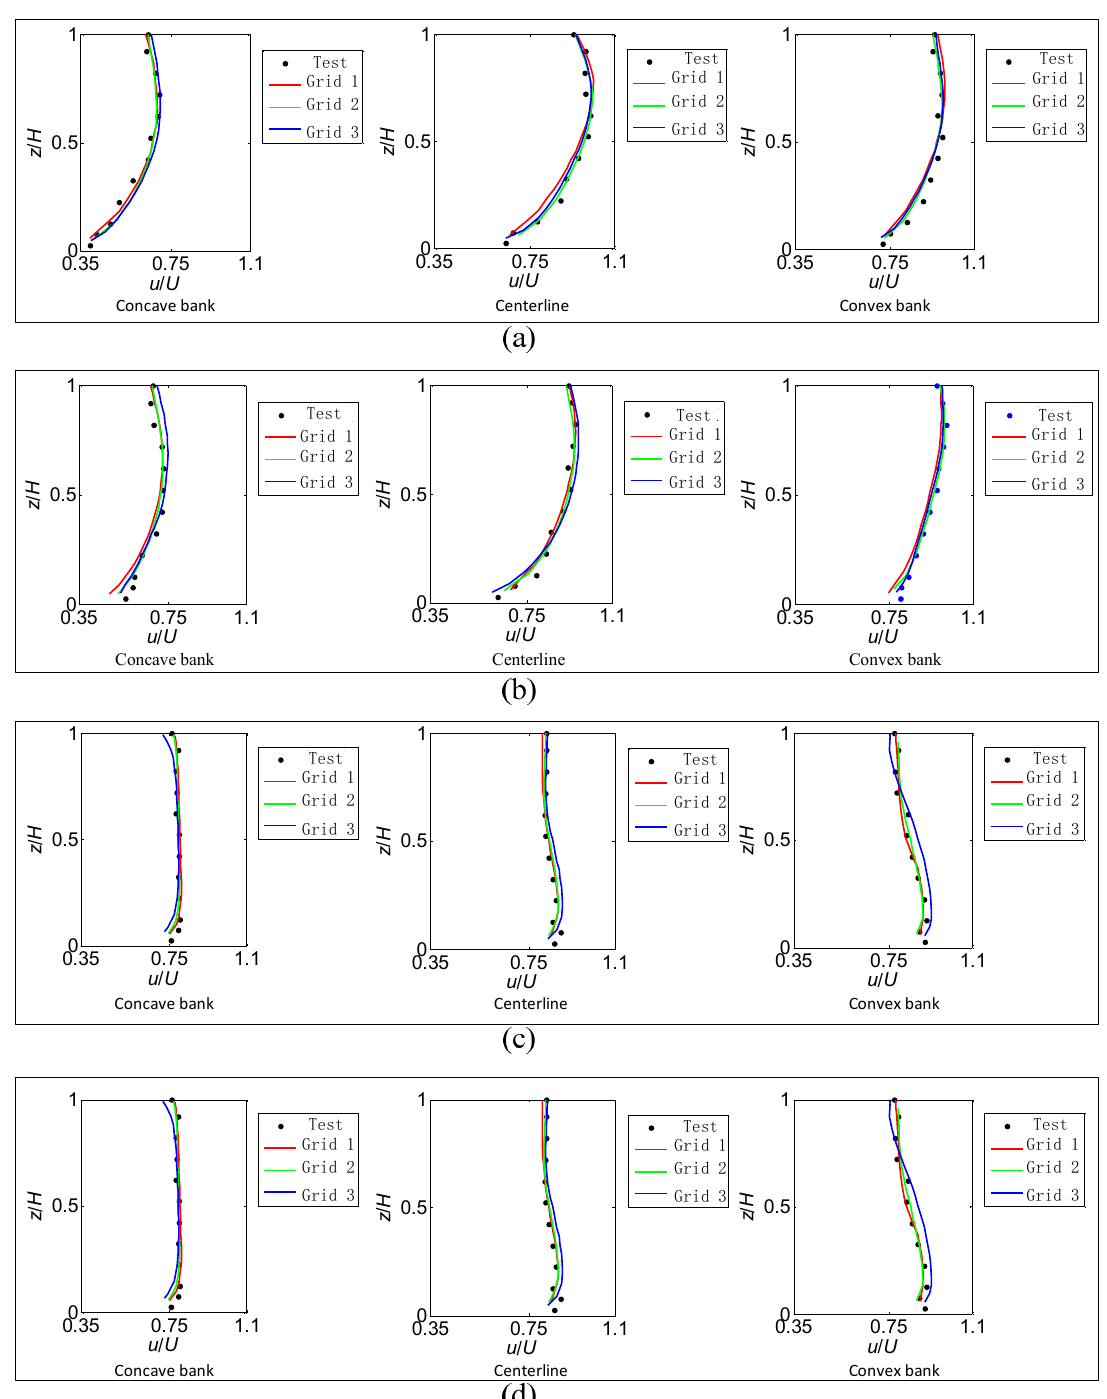
Figure 4. The distributions of time-averaged velocity along vertical line: D0 ( a ), D45 ( b ), D90 ( c ), D135 ( d ).